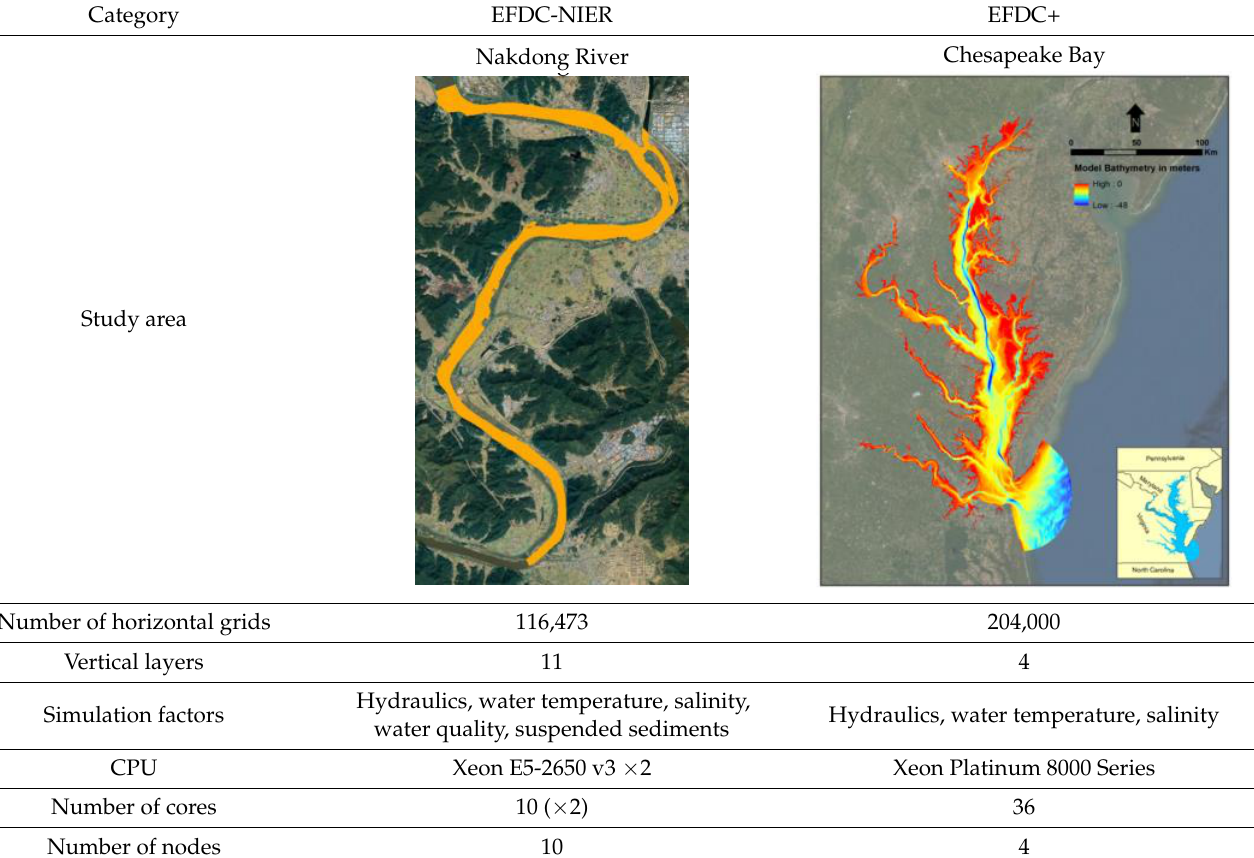
Table A3. Overview of EFDC-NIER and EFDC+ models and the hardware used. Table B1. Overview of EFDC-NIER and EFDC+ models and the hardware used. Table B1. Overview of EFDC-NIER and EFDC+ models and the hardware used.